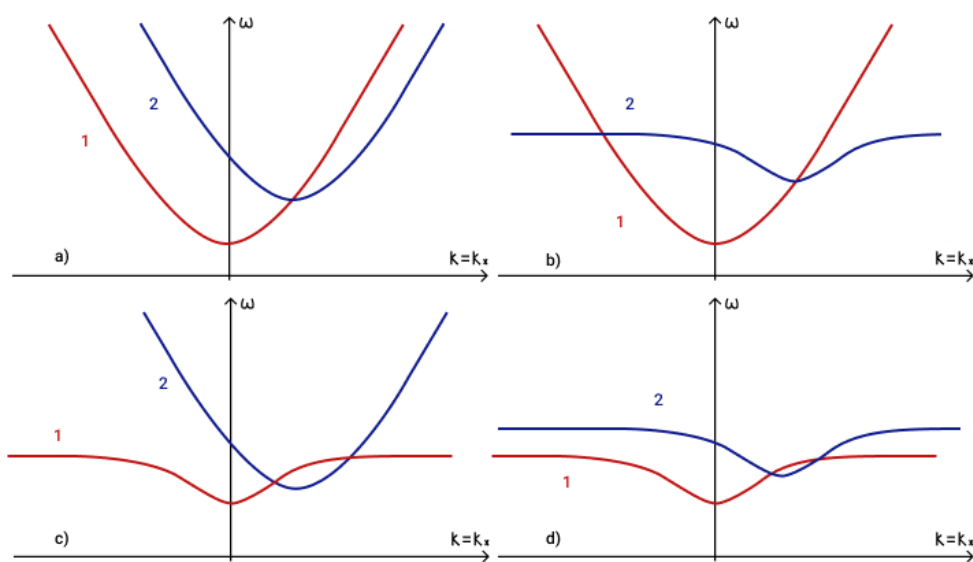
Figure 23. Phase matching conditions for waves in an external vertical magnetic field, namely for ( a ) three magneto-Poincare waves: 1— ω = ω mP ( k x ) , 2— ω = ω mP ( k x − k x magneto-Poincare and one magnetostrophic waves: 1— ω = ω mP ( k x ) , 2— ω = ω ms ( k x − k x ) , ( c ) two magnetostrophic and one magneto-Poincare waves: 1— ω = ω ms ( k x ) , 2— ω = ω mP ( k x c ) + ω ms ( k x ) , ( d ) three magnetostrophic waves: 1— ω = ω ms ( k x ) , 2— ω = ω ms ( k x − ω mP ( k x − k x c c ) + ω ms ( k x ) . k x c c